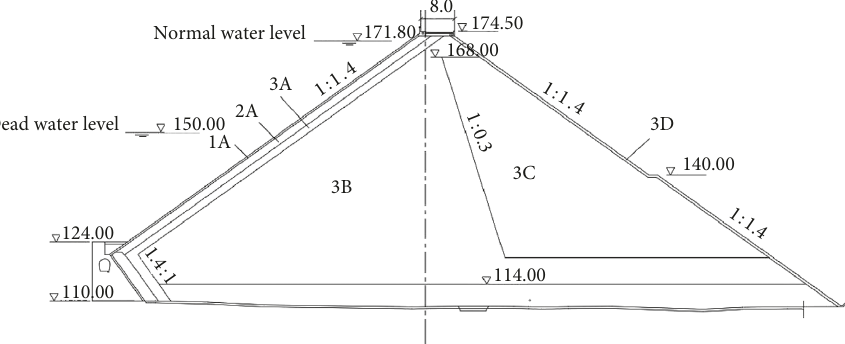
Figure 6: Material zoning in the maximum cross section A-A.